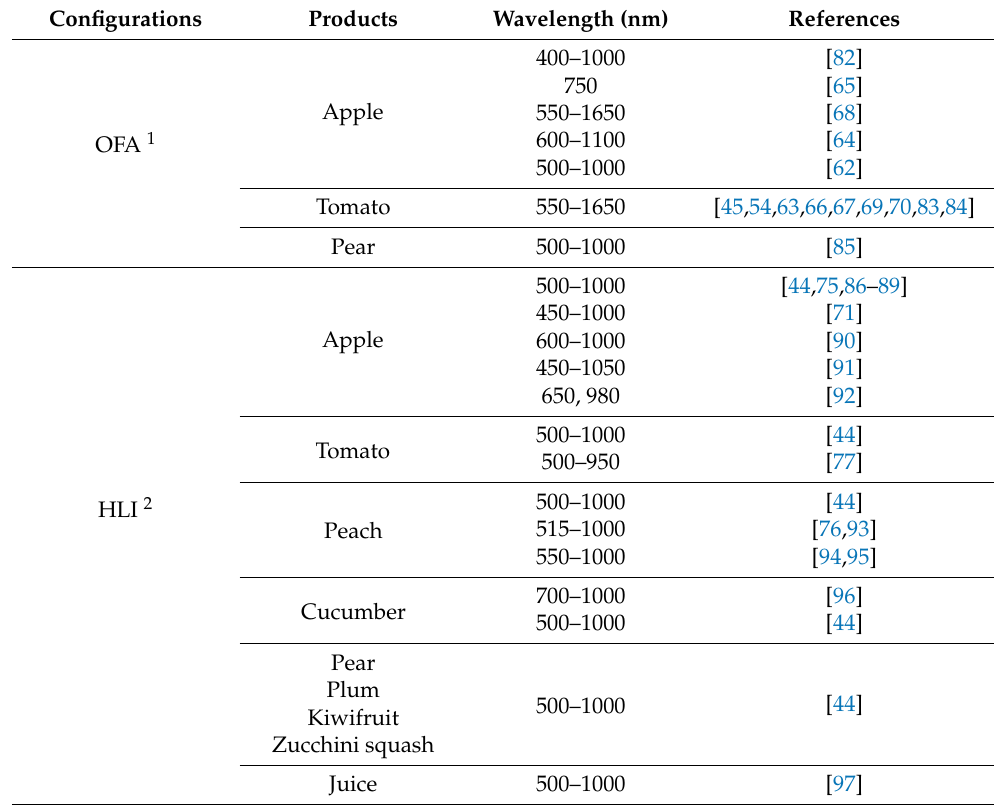
Table 1. SRS configurations of optical fiber arrays and hyperspectral line-scan imaging with different wavelength